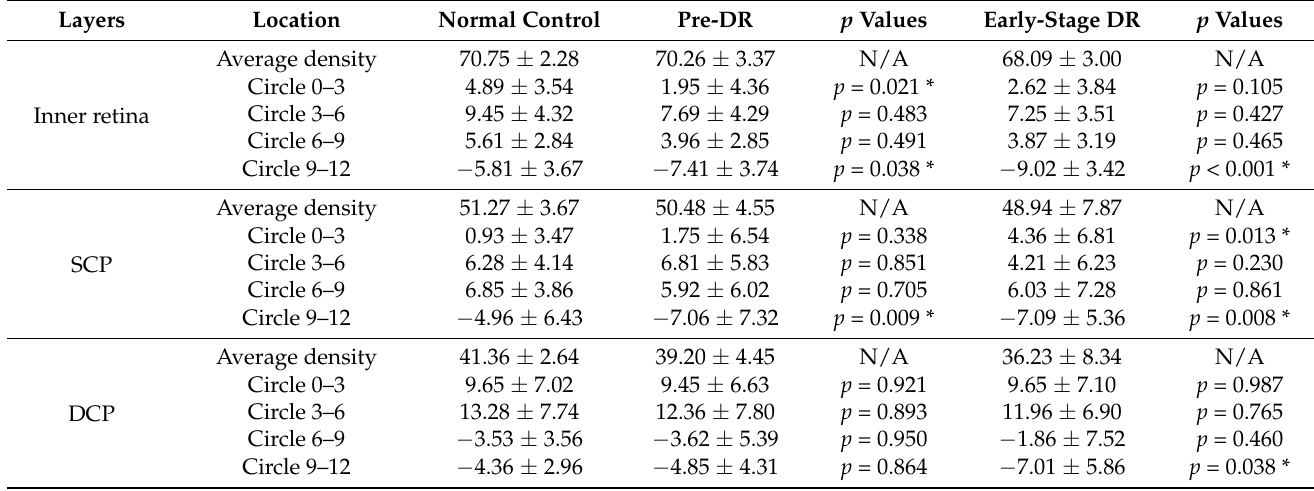
Figure 5. Capillary and CMT changes in different retinal zones. Capillary and CMT changes in different retinal zones (Circle x-y vs. Average density) in patients with early-stage diabetic retinopathy, diabetes mellitus without ophthalmoscopic signs of diabetic retinopathy and non-diabetic subjects of the control group. * indicates a statistically significant difference ( p < 0.05). Table 3. Comparison of capillaries changes in different retinal zones (Circle x-y vs. Average density) in patients with early-stage diabetic retinopathy, diabetes mellitus without ophthalmoscopic signs of diabetic retinopathy and non-diabetic subjects of the control